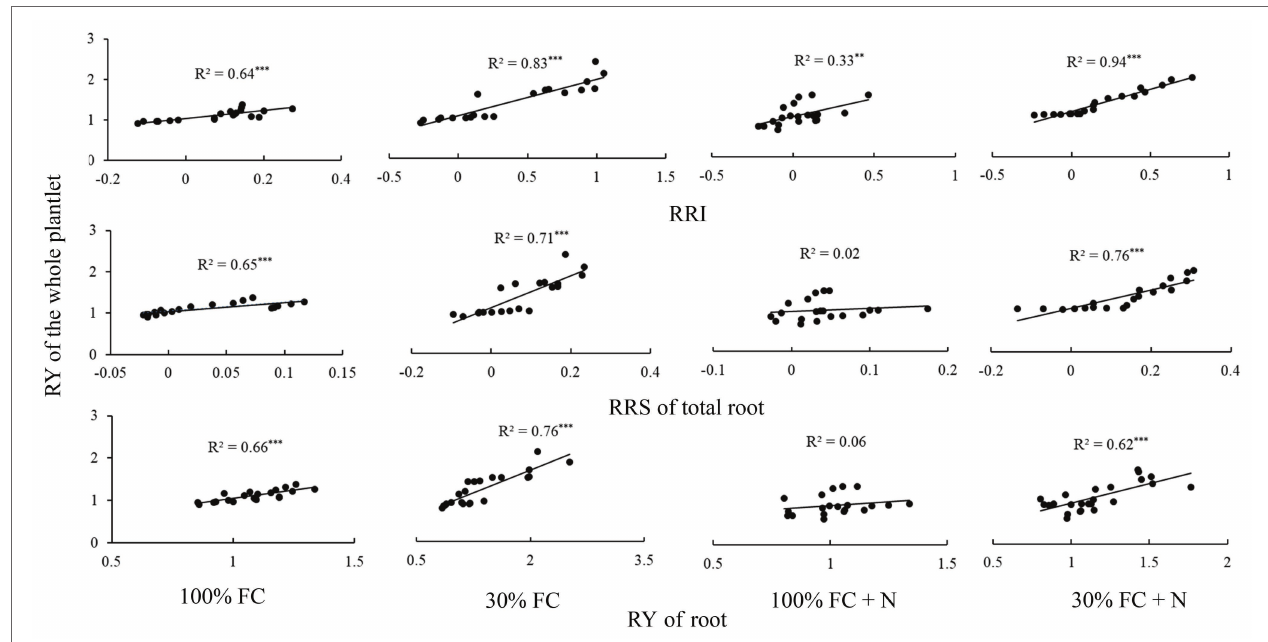
FIGURE 8 | The relationships between the RY of whole plantlet and RRI, RRS, and RY of total root, respectively. One point showed one sample. The solid lines represent the best-fit linear regressions. ** p < 0.01; *** p < 0.001. 100% FC, 100% field capacity; 30% FC, 30% field capacity; 100% FC+N, 100% field capacity and N fertilization; 30% FC+N, 30% field capacity and N